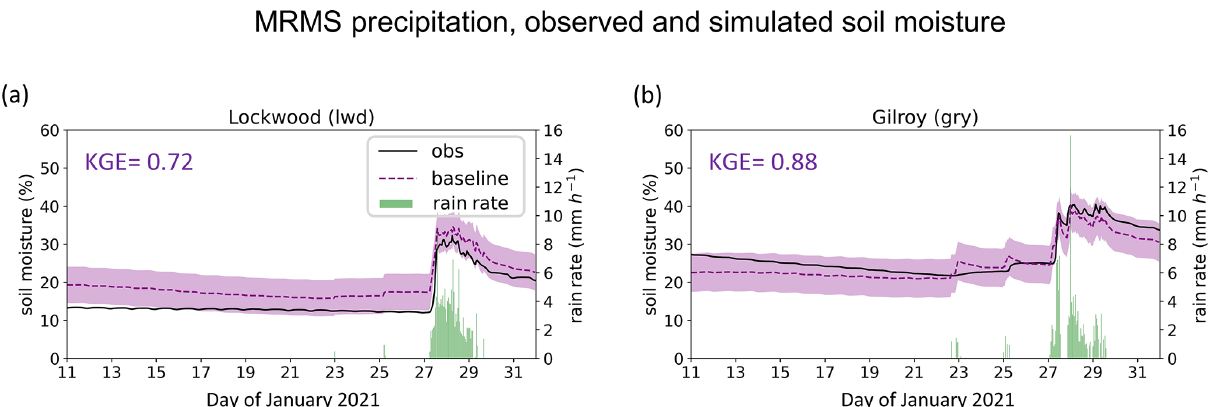
Figure 4. Precipitation and observed and simulated soil moisture at two PSL soil moisture stations. MRMS precipitation from 11–31 Jan- uary 2021 (mmh − 1 ; green bars) and observed (%; black line) and simulated volumetric soil moisture 10cm below ground in the baseline simulation (%; purple dashed line) at PSL sites (a) Lockwood (lwd) and (b) Gilroy (gry). Envelope of purple shading depicts ± 1 standard deviation of model-simulated soil moisture. KGE scores are provided at the top left for each